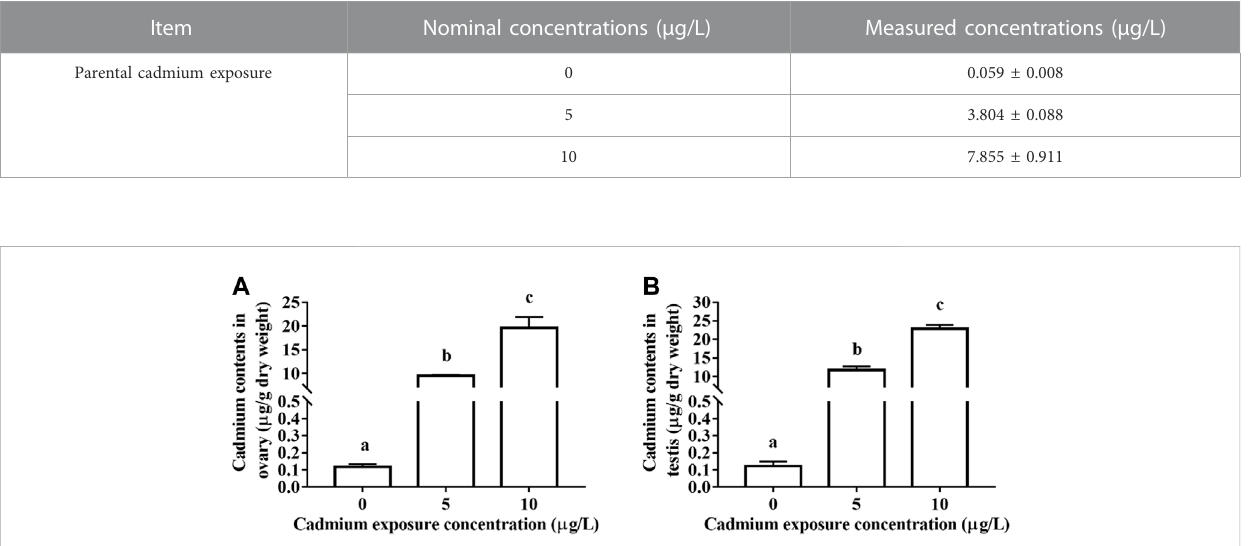
rare minnows in 5 and 10 μ g/L Cd exposure resumed the spawning rhythm (Figure 2B). Furthermore, the spawning interval in the 10 μ g/L Cd exposure group was 8.19 ± 4.42 days, a signi fi cant increase compared to that of the control group (Table 2, p < 0.05). The intervals in the 5 μ g/L Cd exposure group were not signi fi cantly different from the control (Table 2, p > 0.05) .